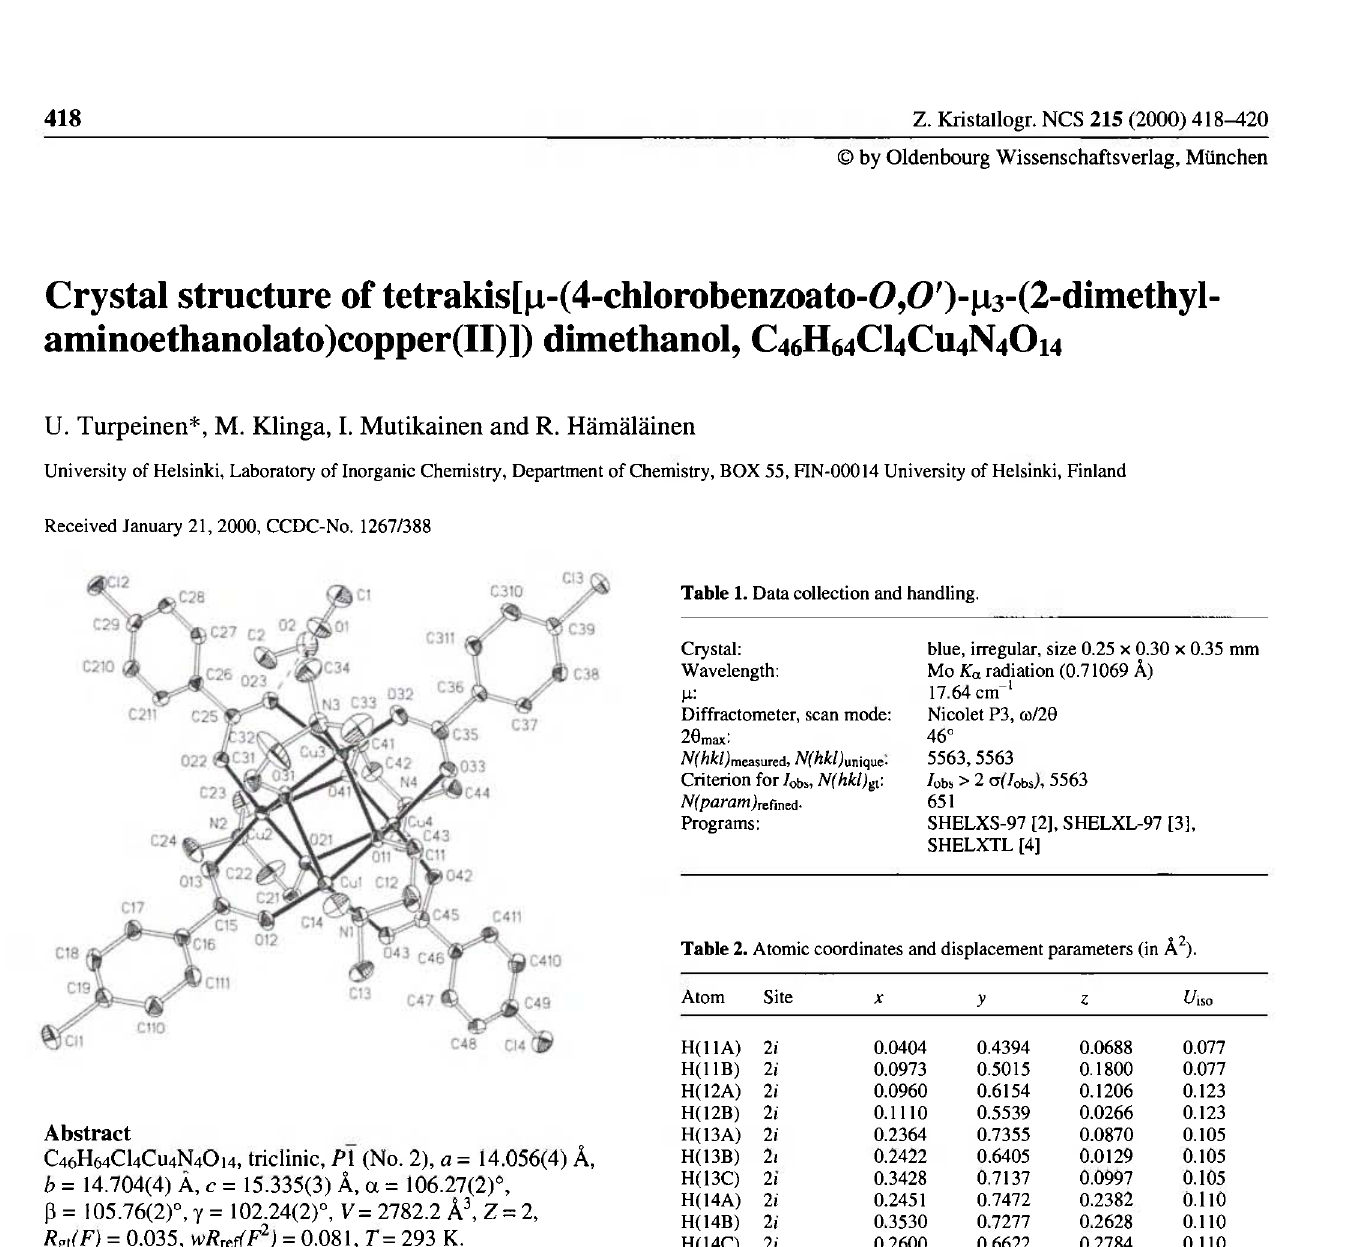
Table 2. Atomic coordinates and displacement parameters (in Ä 2